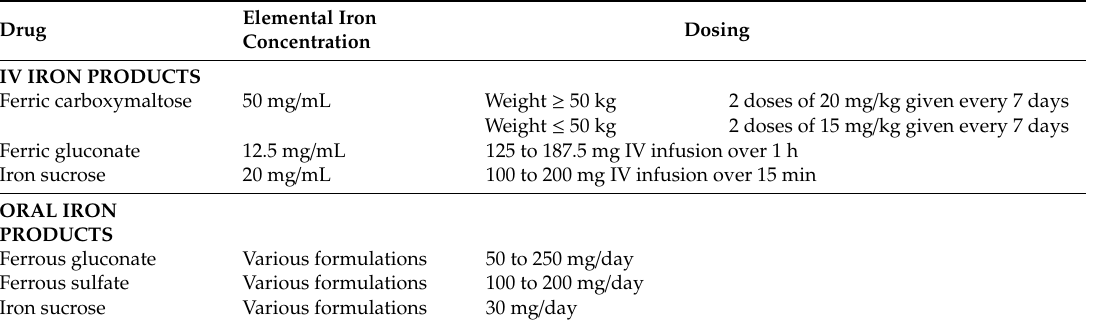
Table 1. Available oral and parenteral iron preparations with standard dosing. The list is not exhaustive; other oral and parenteral iron formulations may be